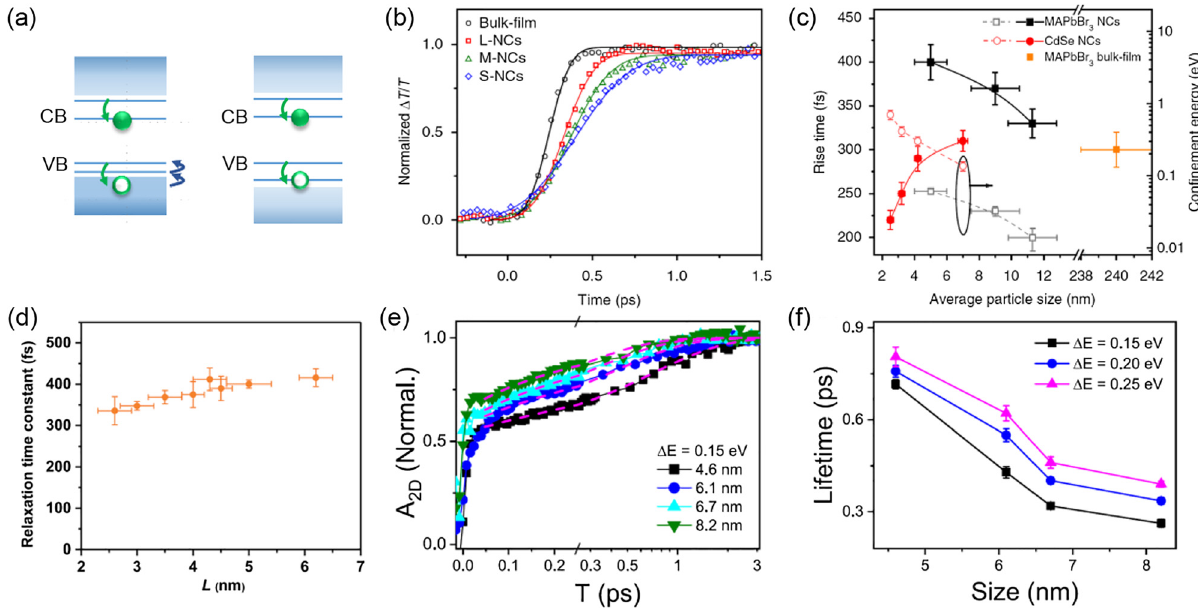
Figure 10: (a) Schematic of hot carrier cooling via the intraband Auger-type energy transfer with the electron-hole scattering (left), and intrinsicphononbottleneckeffectinperovskitenanocrystalswithsymmetricdiscreteenergylevels(right).(b)Normalizedbleachingdynamics probedat theband-edgeforMAPbBr 3 nanocrystals andbulk fi lmat low carrierdensity.(c)Size-dependentband-edgebleachingrise timeand related quantum con fi nement energies for perovskite nanocrystals under weak quantum con fi nement (black square) and CdSe nanocrystals (red circle) with initial electron-hole pair per nanocrystal of ∼ 0.1. (b) and (c) Adapted and reproduced with permission [94]. Copyright 2017, Nature Publishing Group. (d) In strongly con fi ned CsPbBr 3 nanocrystals (2.6 – 6.2 nm), the hot carrier relaxation time estimated by TA spectroscopyisweaklydependentonthenanocrystalsize.Reproducedwithpermission[136].Copyright2019,TheRoyalSocietyofChemistry. (e) Normalized time-resolved traces of 2DES signal probed at the band edge from CsPbI 3 nanocrystals of different sizes with excess energy of Δ E = 0.15 eV. (f) Size-dependent lifetime parameters for hot carrier relaxation extracted from 2DES signals. (e) and (f) Reproduced